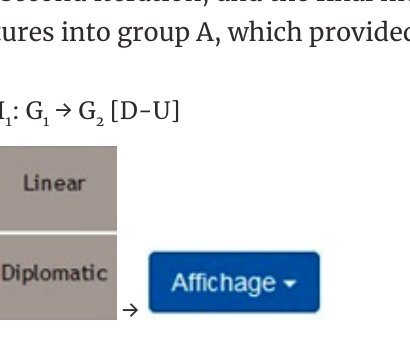
), on the bottom-left toolbar, derived from the EVT 1